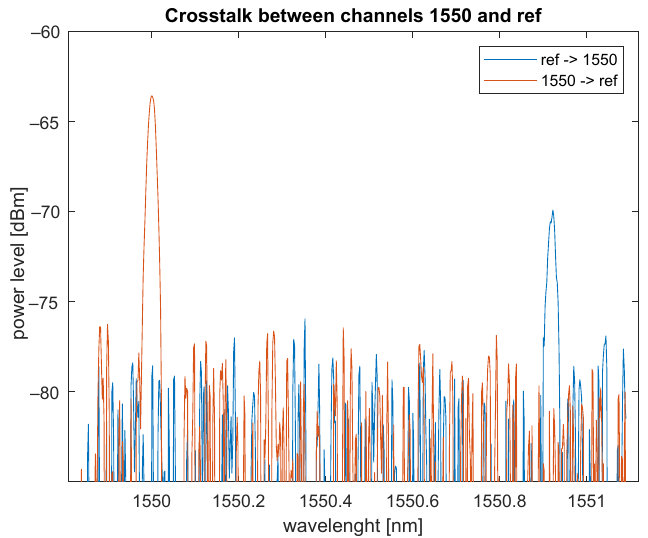
Figure 11. Crosstalk between REF and PASS ports in CWDM ADD/DROP.